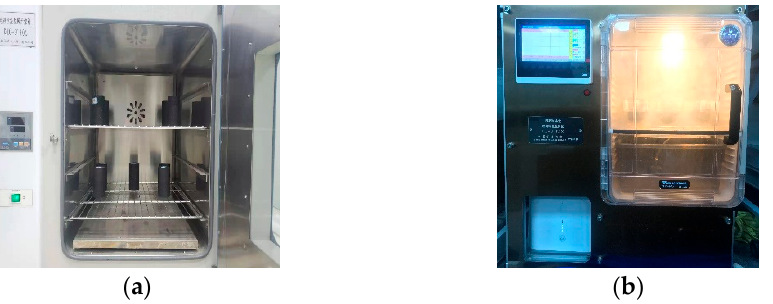
Figure 4. ( a ) 101-2 Electric thermostatic dry box; ( b ) rock moisture weighing instrument.